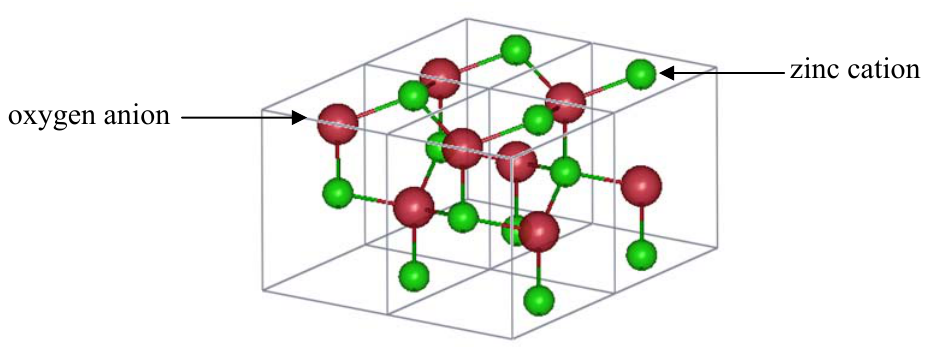
Figure 6. ZnO wurtzite structure (four unit cells are